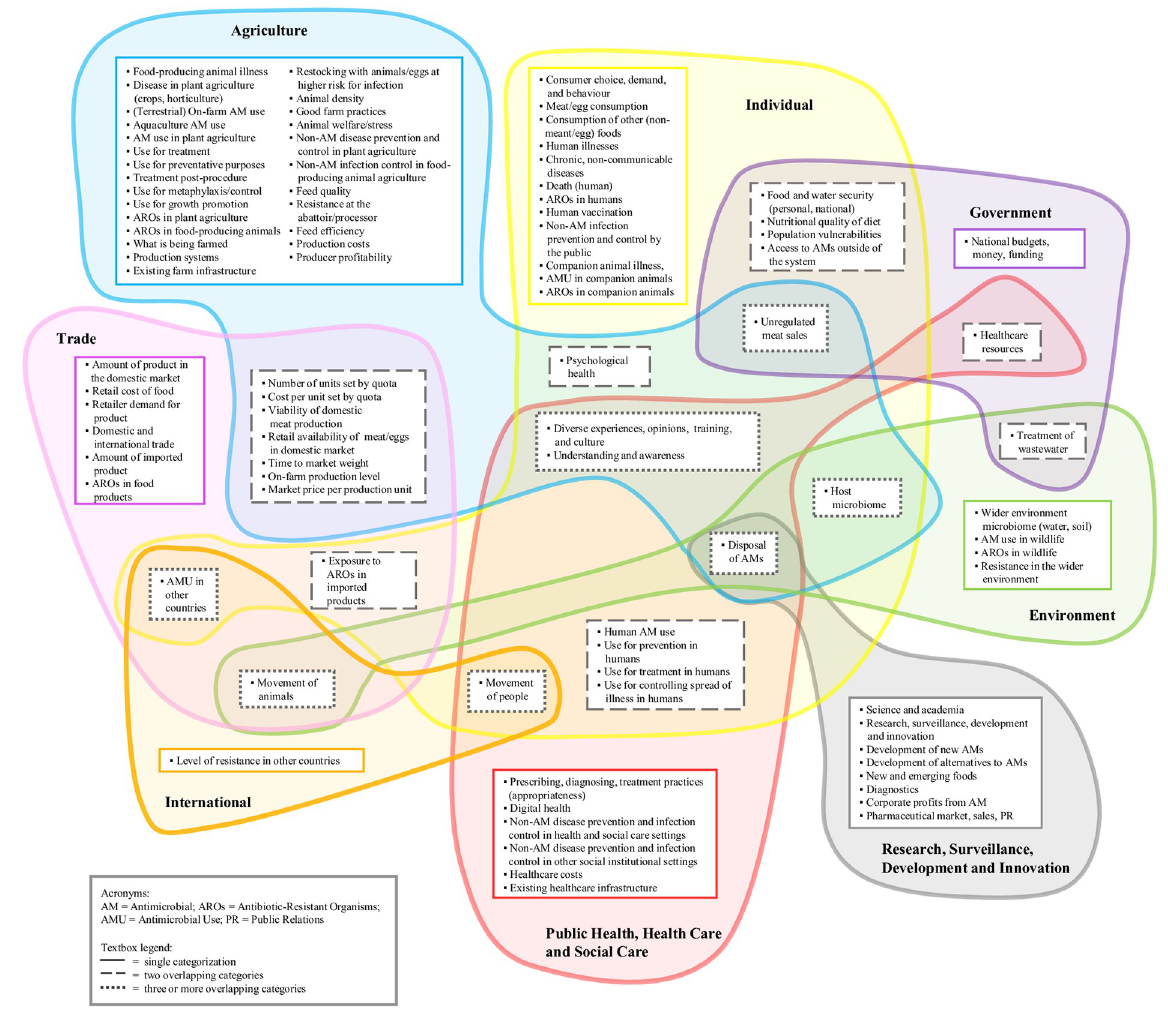
Fig 1. 91 CLD Factors by 8